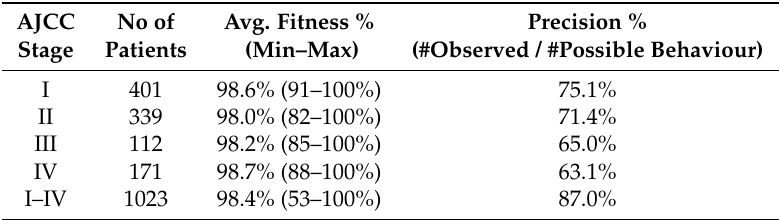
Table 2. Using the Multi-perspective Process Explorer (MPE), for each stage log and the combined log (I–IV) the average fitness and precision were calculated in regard to the respective guideline models. AJCC Avg. Fitness %